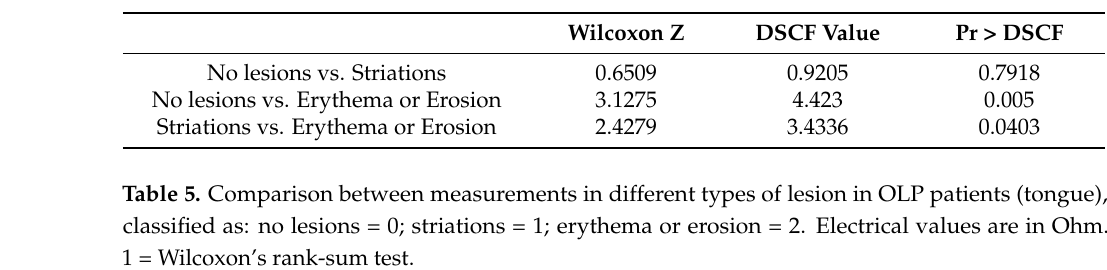
Table 4. Comparison between types of lesions in the right cheek using the Dwass–Steel–Critchlow– Fligner multiple comparison procedure.